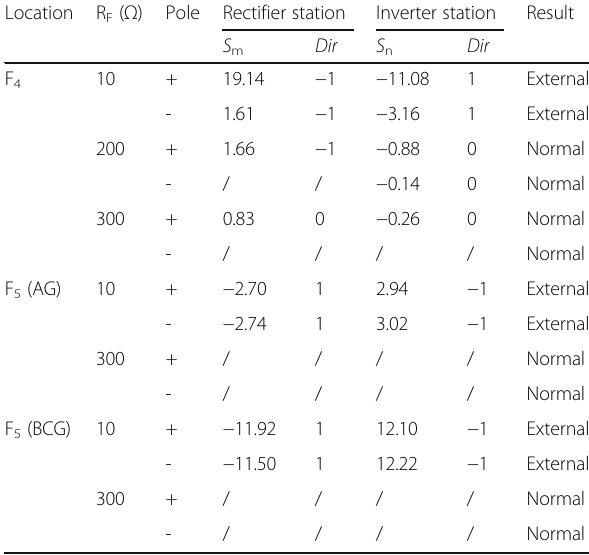
Table 7 Simulation results for faults outside the DC line